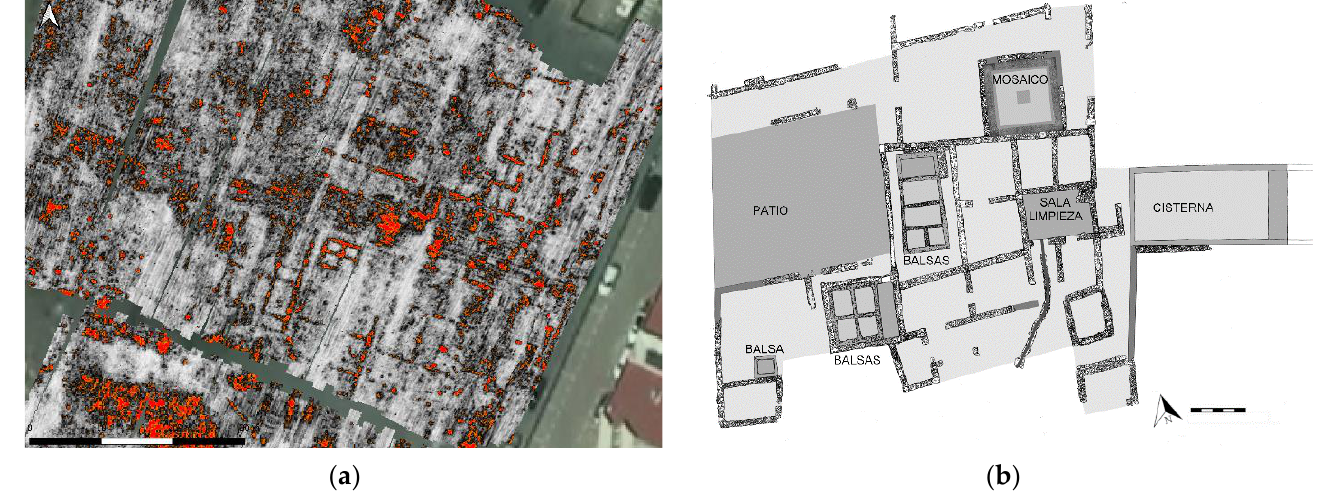
Figure 22. (a) Detailed view of the northern part of the study area showing the different alterations of Set 4 at -0.89 m. (b) Complete plan of the La Picola cetaria showing its main spaces and infrastructures [7] (p. 108, Figure 18).